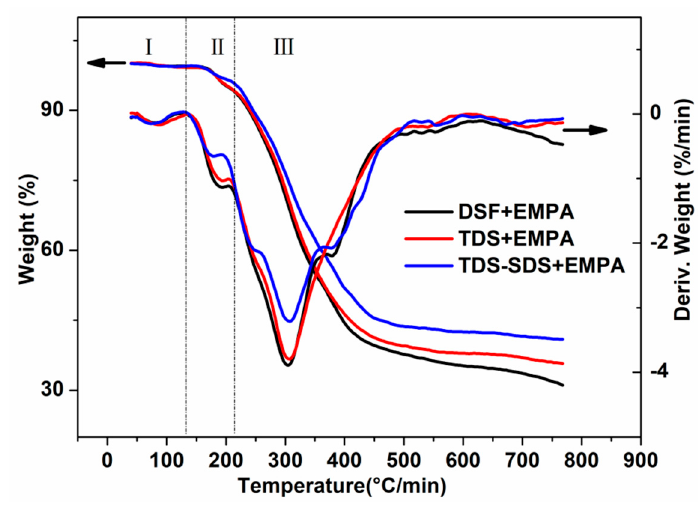
Figure 9. Thermogravimetric analysis (TGA) and DTG curves of various DSF-based